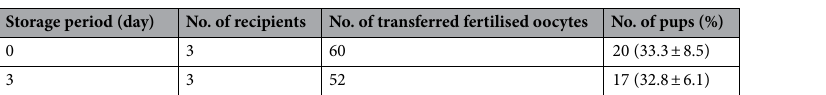
Storage period (day)